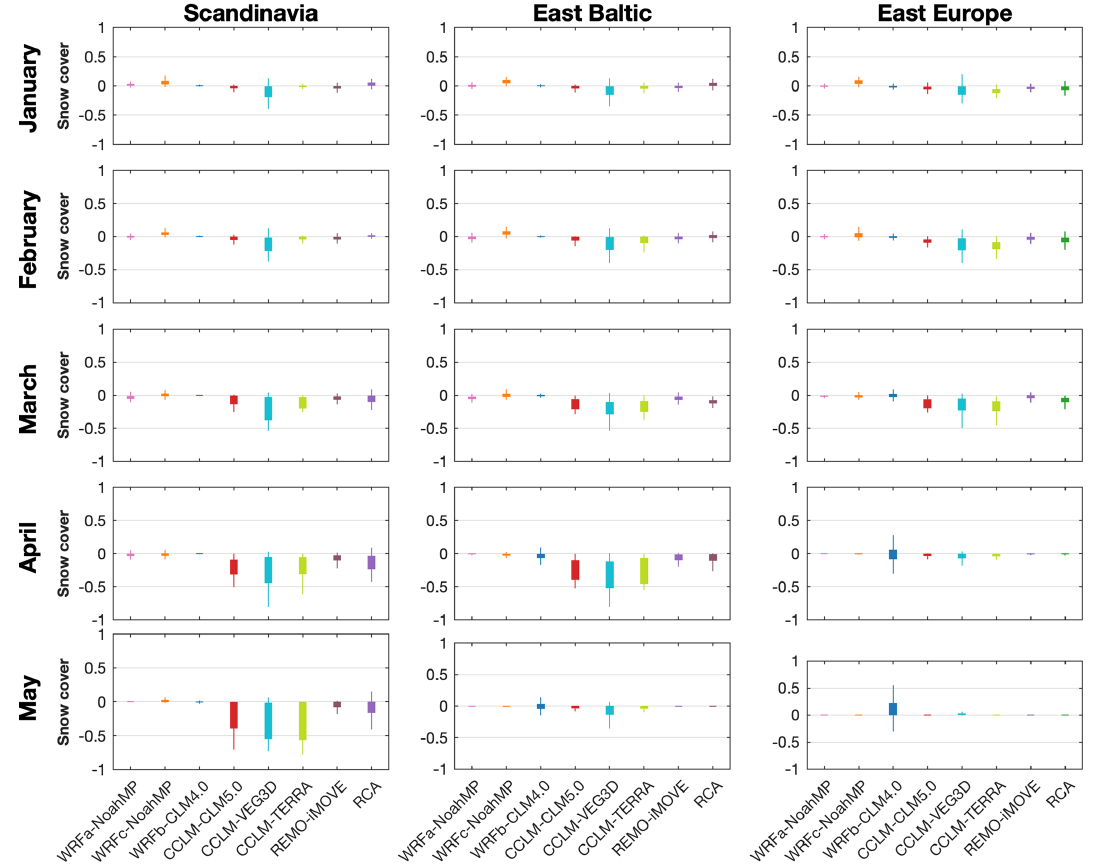
Figure 5. Impact of afforestation (FOREST − GRASS) on snow cover fraction simulated by the CORDEX FPS LUCAS models. The box plots indicate the spatial variability in the difference between the FOREST and GRASS experiments. Only differences that are statistically significant at the 95% confidence level are considered. Statistical significance was determined using Student’s t